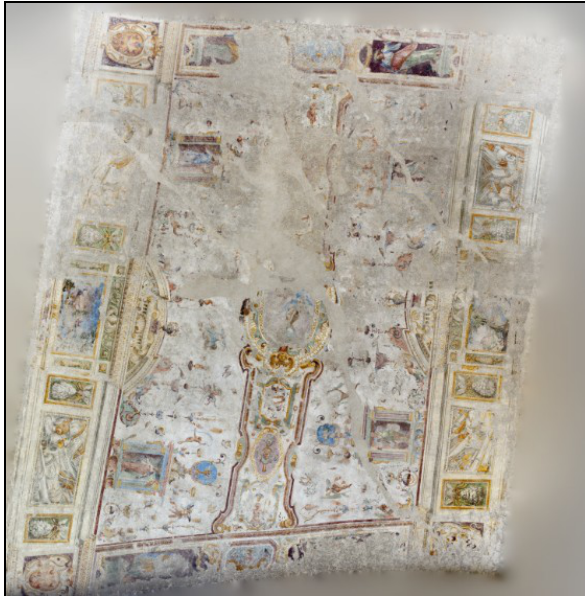
Figure 26 – Final unfolded textured